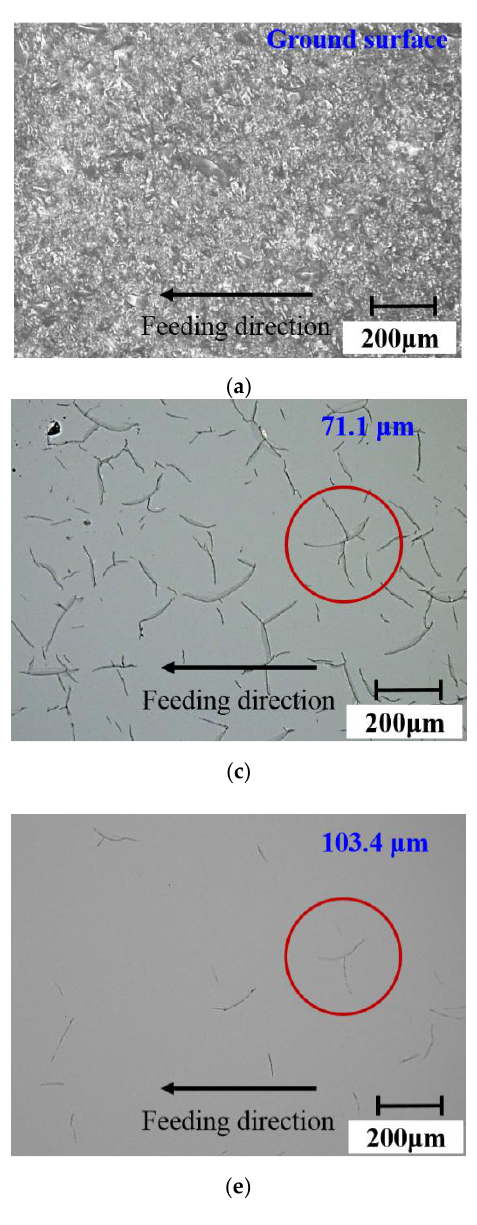
Figure 7. Distribution characteristics of cracks at different subsurface depths under the action of the undressed wheel, subsurface depth ( a ) 0 μm ( b ) 40.7 μm ( c ) 71.1 μm ( d ) 98.6 μm ( e ) 103.4 μm ( f ) 111 μm. The red circle positions in the figure show the variation in a bifurcation crack with subsurface depth.